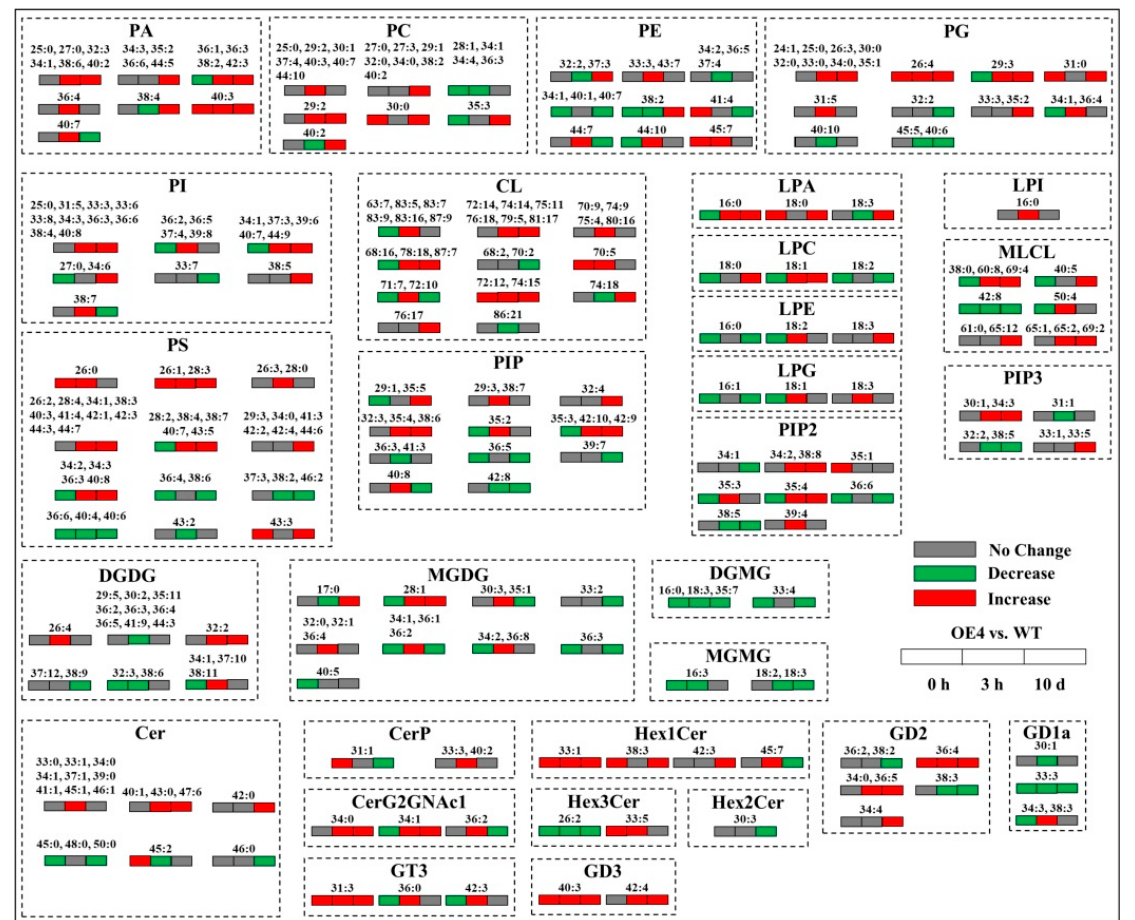
Figure 7. Changes in lipid molecular species of different lipid classes in leaves when the transgenic Arabidopsis thaliana overexpressing the TrSAMS was compared with the wild-type (WT) Arabidopsis thaliana during heat stress (OE4 vs. WT). Red indicates a significant up-regulation, green indicates a significant down-regulation, and gray indicates no significant change.